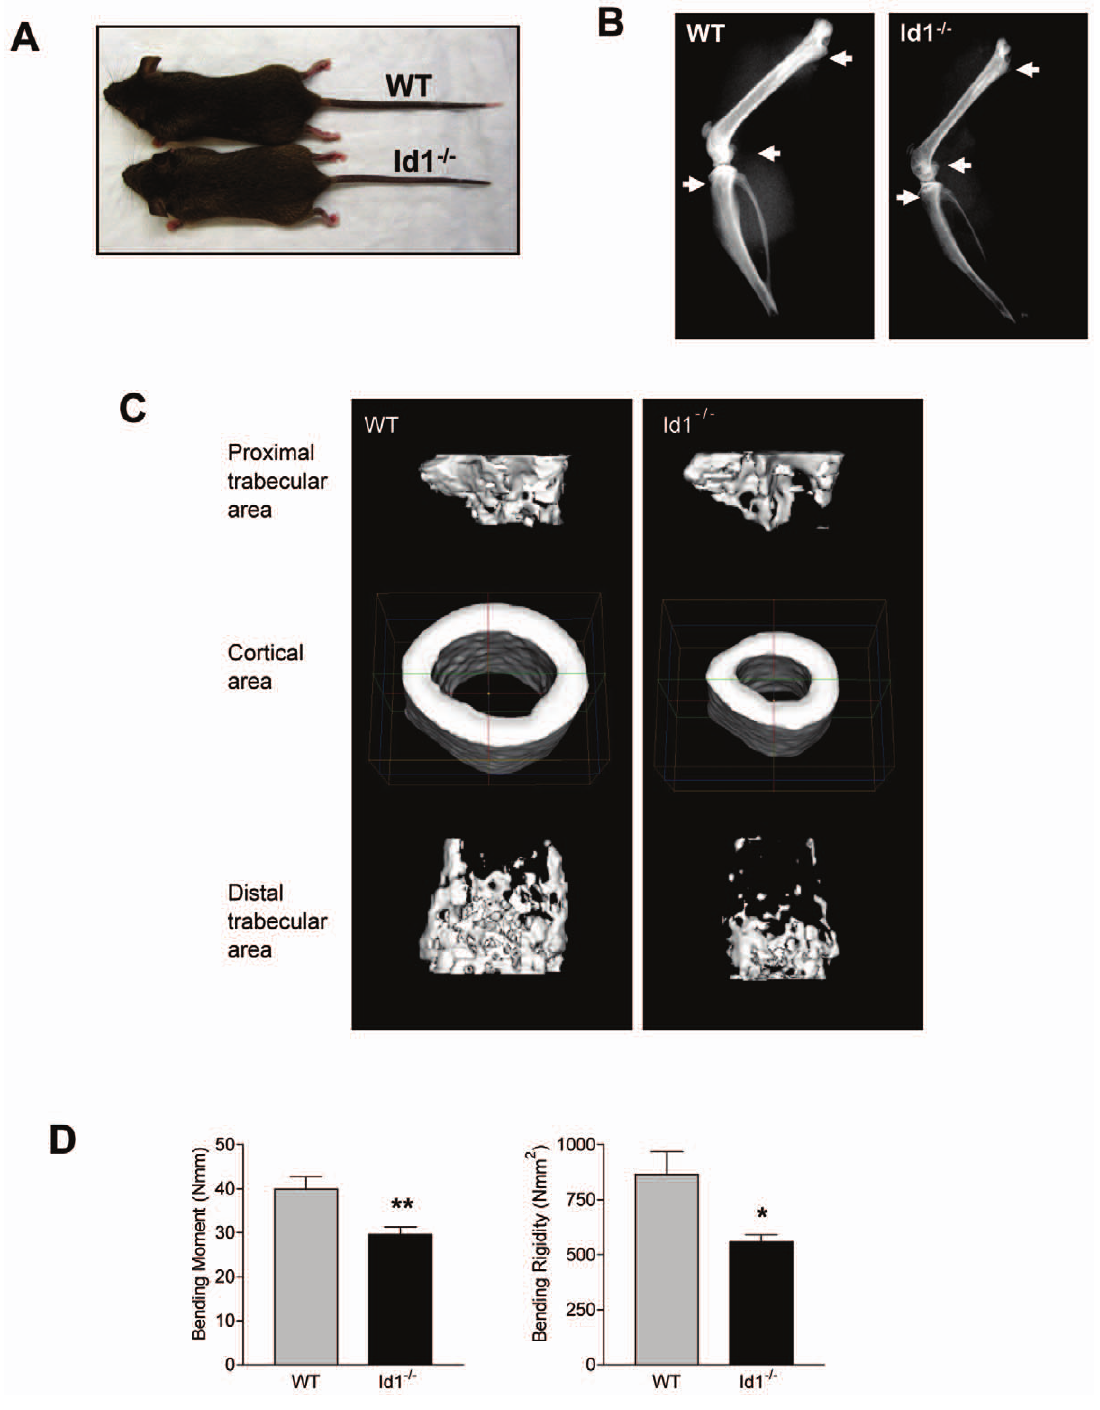
Figure 1. Skeletal phenotype of Id1 2 / 2 and wild-type mice at 6 weeks of age. (A) Photograph of a representative Id1 2 / 2 and wild-type mouse. (B) X-ray microradiographs of hindlimbs. White arrows indicate trabecular bone regions. (C) Representative micro-CT images of the femoral trabecular and cortical regions in wild-type and Id1 2 / 2 mice. (D) Three-point bending tests for evaluating the mechanical strength of femurs from wild-type (n=8) and Id1 2 / 2 (n=8) mice. The parameters measured include the bending moment and the bending rigidity (*P , 0.05, **P , 0.01). Error bars represent 6 S.E.M.